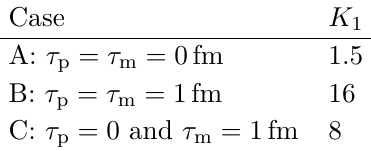
Table 1 . Values of K 1 obtained by fitting ALICE R AA [58] with p T > 6 GeV data for the 20 - 30% √ centrality class in s NN = 2 . 76 TeV Pb-Pb collisions for the three different cases analyzed in this paper (see figure